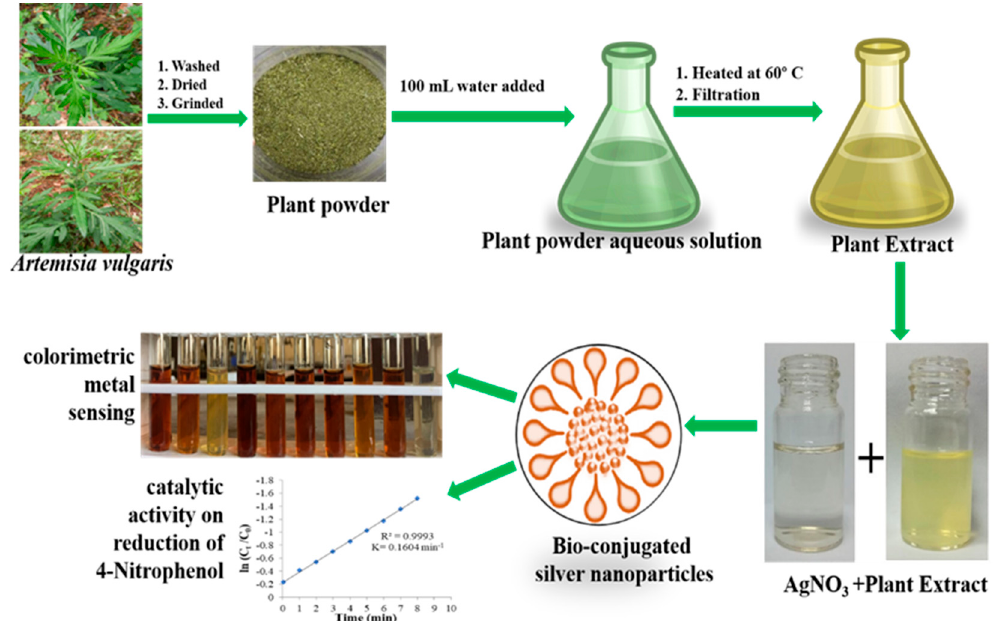
Scheme 3. Schematic diagram representing preparation of plant extract and its